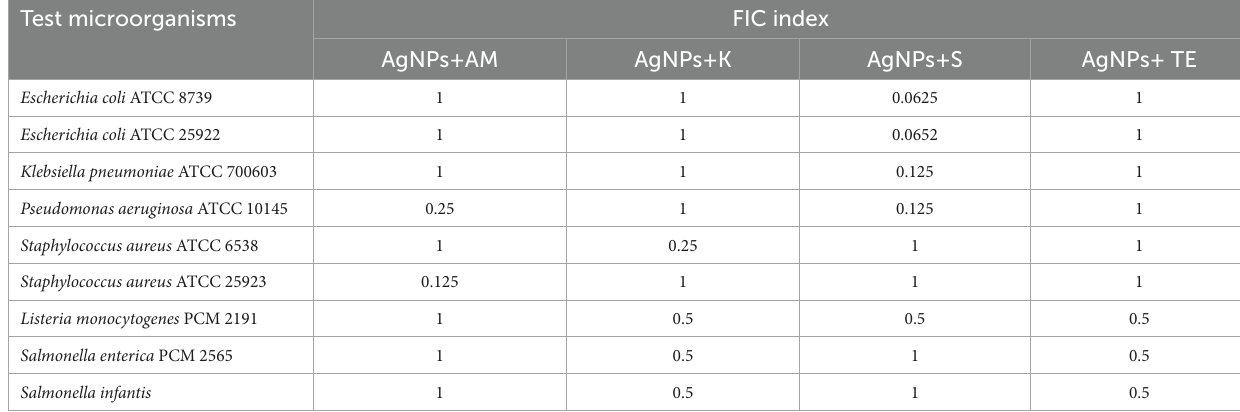
TABLE 3 FIC index values of AgNPs in combination with antibiotics: ampicillin (AM), kanamycin (K); streptomycin (S), and tetracycline (TE) against bacteria. Test